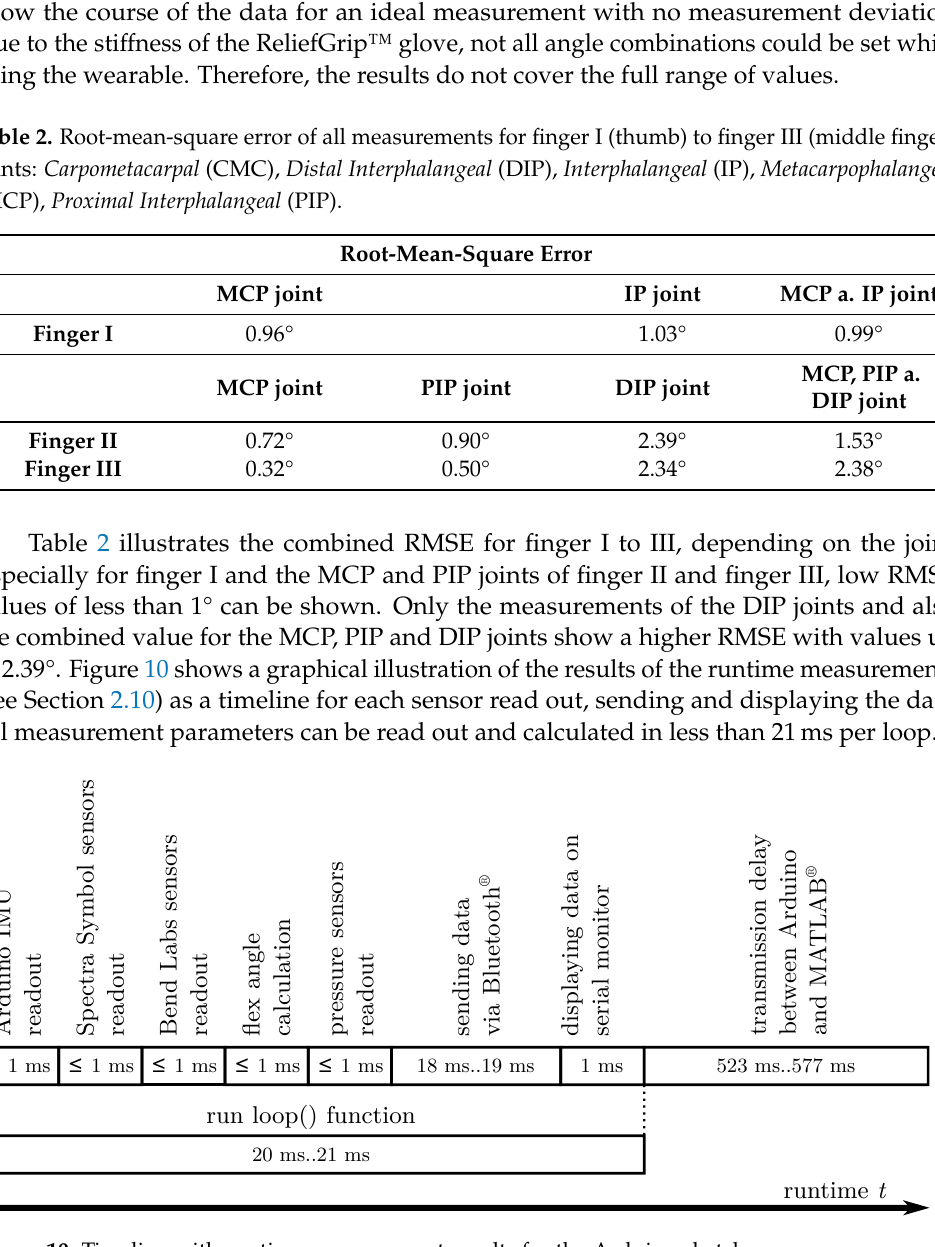
Figure 10. Timeline with runtime measurement results for the Arduino